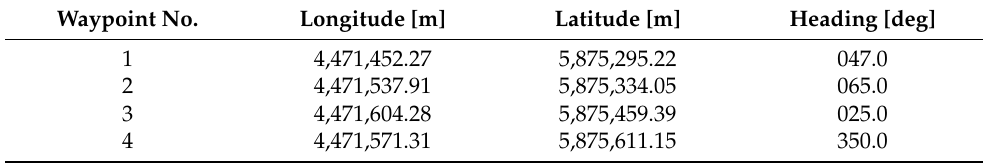
Table 3. Model Predictive Control (MPC)–Line-of-sight (LOS) trajectory tracking waypoints data. Waypoint